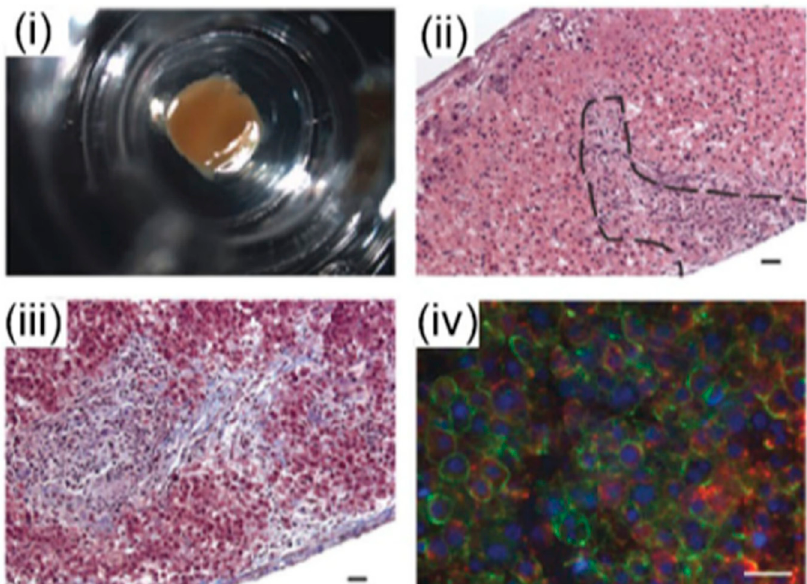
Figure 6. Organovo’s mini liver tissue: ( a ) A macroscopic image of liver tissue housed in a 24-well transwell, ( b ) Hematoxylin and eosin (HE) staining of a tissue cross-section, (c) extracellular matrix (ECM) deposition assessed by Masson’s trichrome staining, and (d) Ι immunohistochemistry (IHC) staining of the parenchymal compartment for E-cadherin (green) and albumin (red) [71].